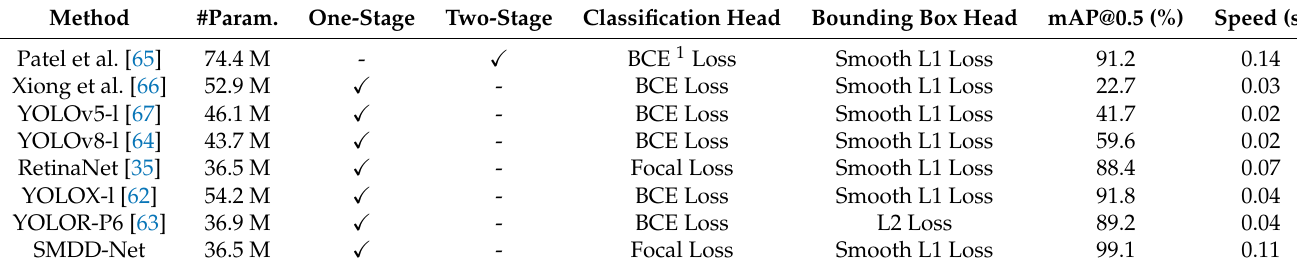
Table 3. Comparison of SMDD-Net with other